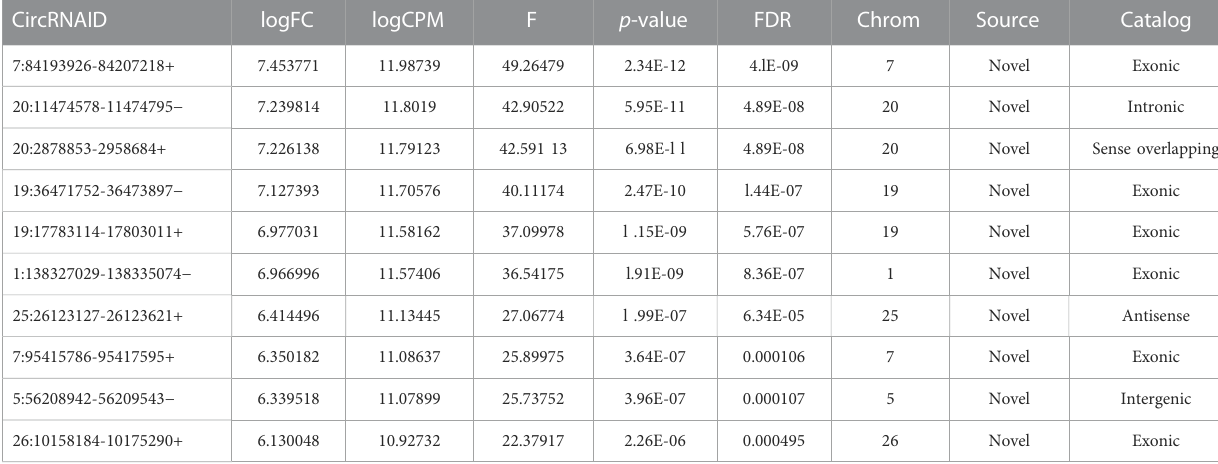
TABLE 3 Top 10 upregulated circRNAs.